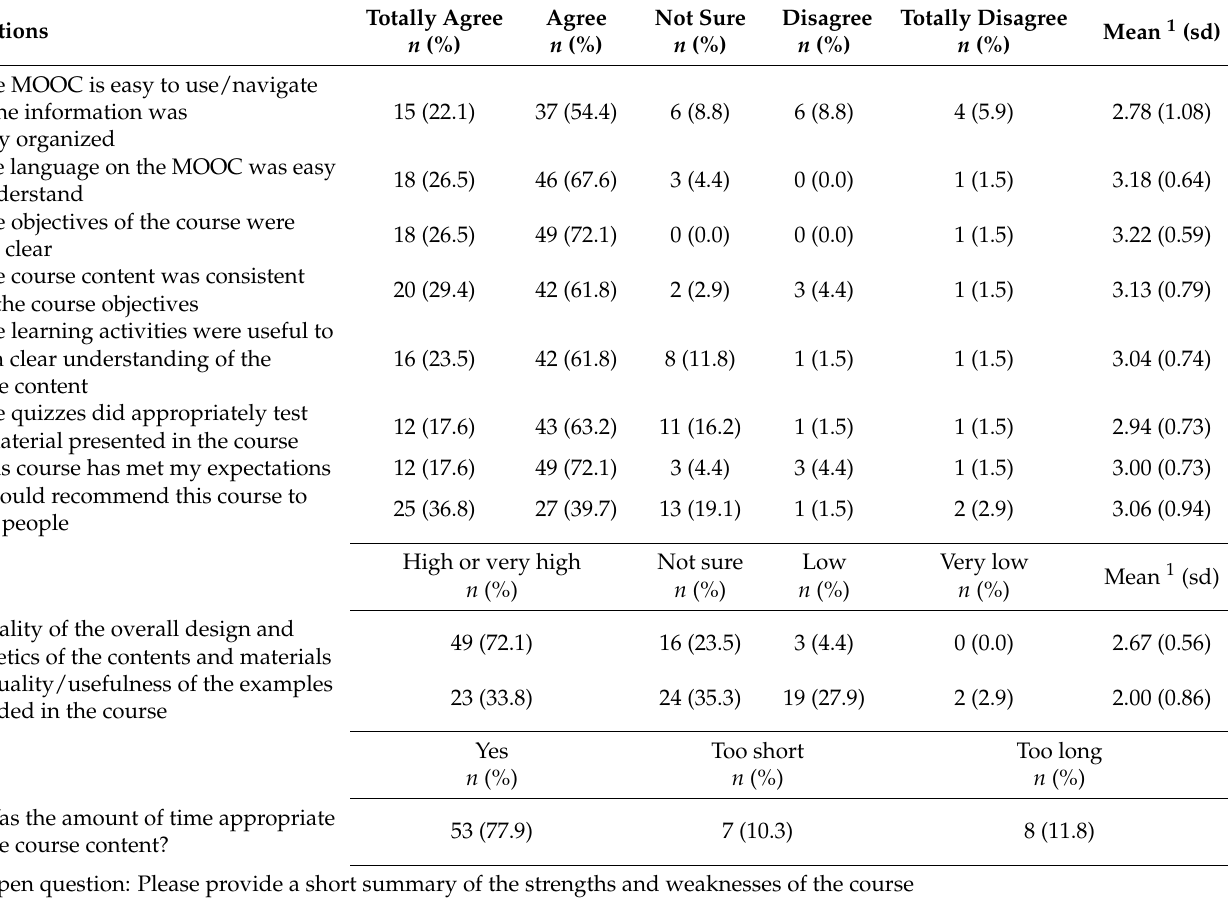
Table 3. Acceptability of the MOOCs ( n = 68).